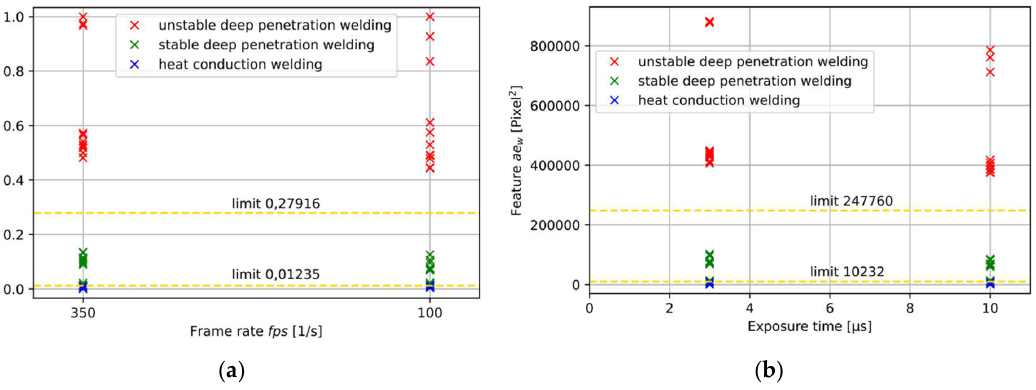
Figure 7. ( a ) Normalized feature value over different OCT frame rates for welds in different process regimes; ( b ) Feature value over different OCT exposure times for weld results in different process regimes. Categorization limits for different weld regimes can be seen as yellow dotted line.